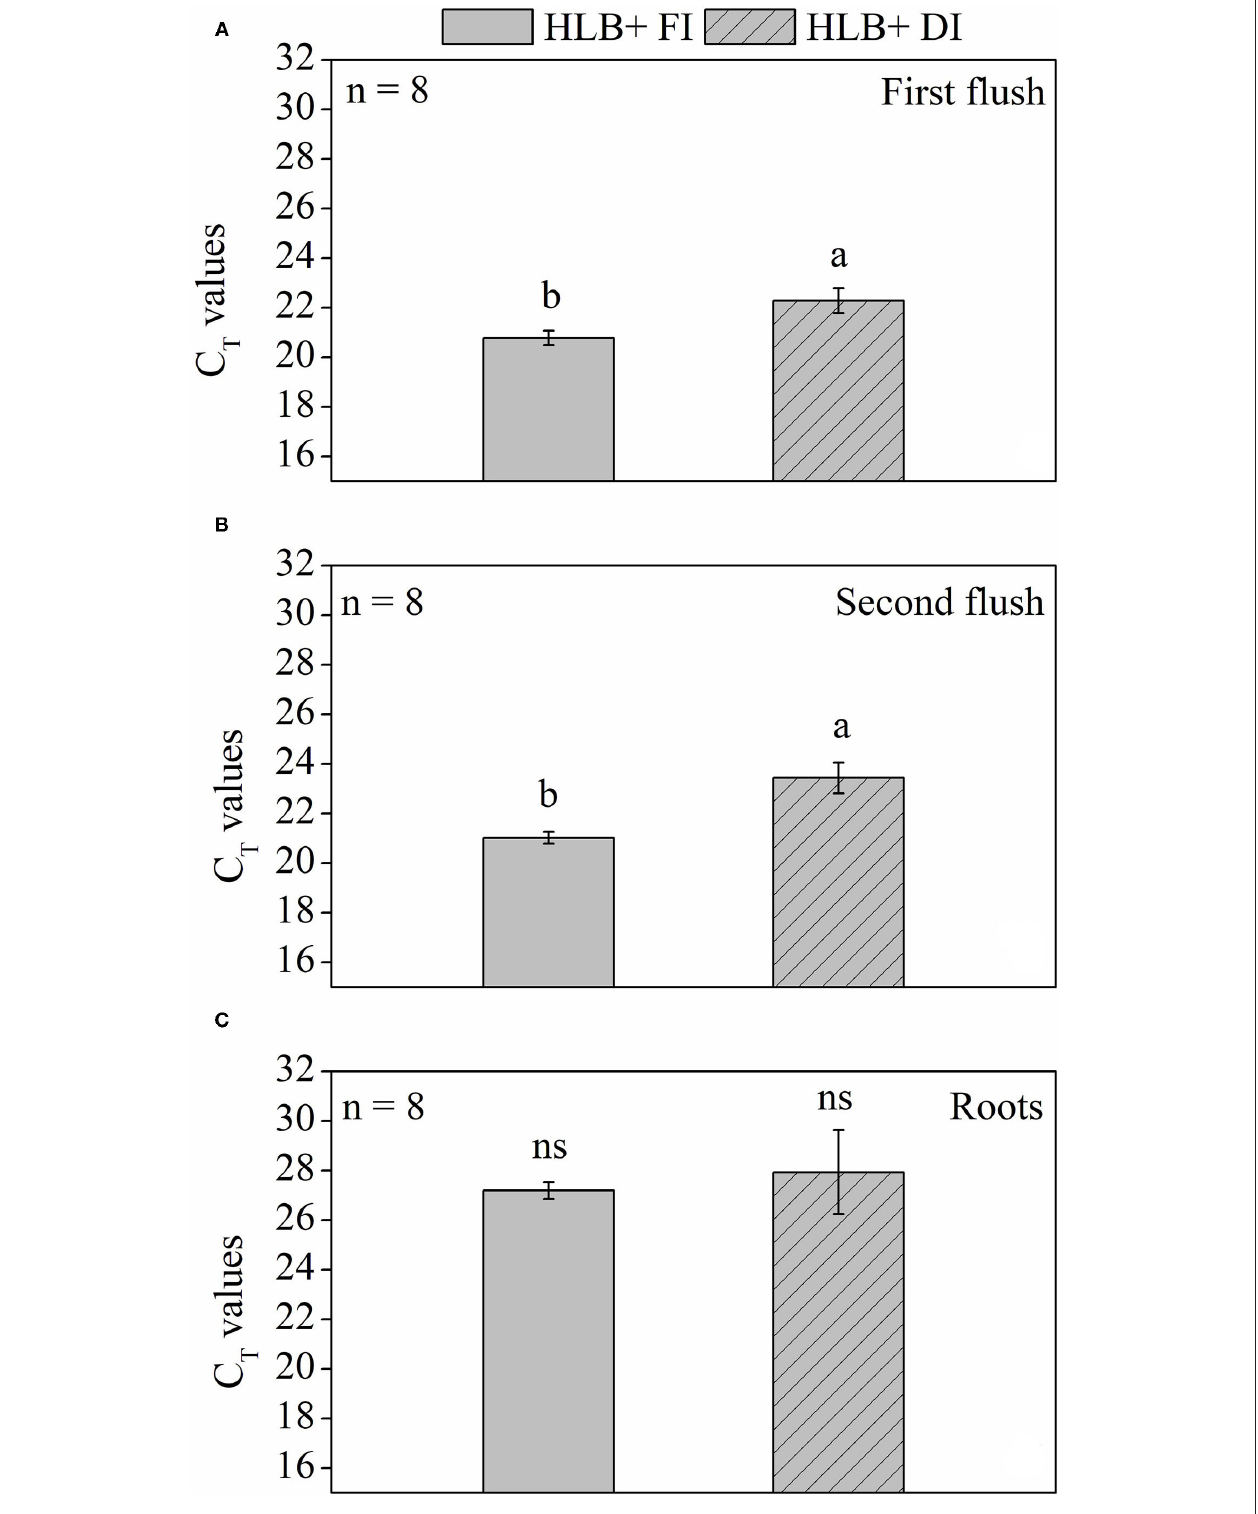
FIGURE 9 | Cycle threshold (C T ) values of leaves from the (A) first and (B) second vegetative flush and fine roots (C) of “Valência” orange trees [ Citrus sinensis (L.) Osbeck] grafted on citrumelo “Swingle” rootstock [ Citrus paradisi Macfad. x Poncirus trifoliata (L.) Raf.] infected with “ Ca . Liberibacter asiaticus” and exposed to two water management treatments: fully irrigated (FI) and deficit-irrigated (DI) 225 days after transferring the plants to the 12-L pots. Means followed by the same letter do not differ according to unpaired Student’s t -test at 5% probability. ns indicates no statistical difference. Values are mean ± SE ( n = 8).